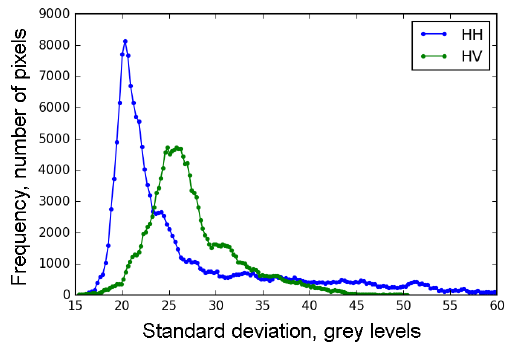
Figure 7. Frequency distribution of radar backscatter standard de- viation using a 34 × 34 pixels sliding window (step = 1 pixel) on a 1000 × 1000 pixels sub-image from image pair Fram Strait (Ta- ble 1). The radar backscatter is scaled to range 0–255 using Eq. (2). The considered sub-image covers pack ice, marginal ice zone and small parts of open water. Results for HH are shown in blue and HV in green.